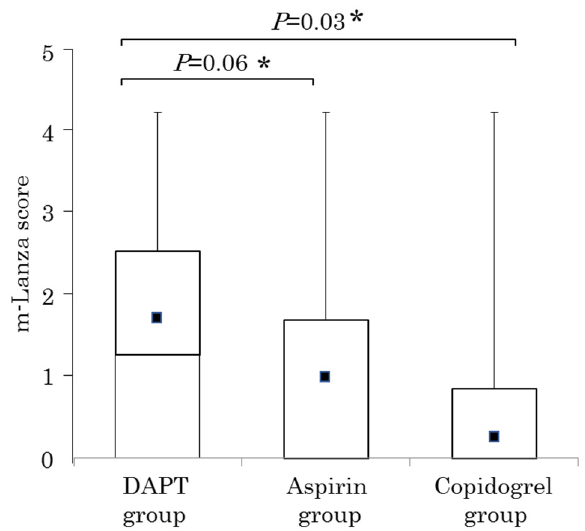
Figure 2. Box plots of the modified Lanza score (m-Lanza score) of the DAPT group, aspirin group, and clopidogrel group. ■ indicates the mean m-Lanza score. The m-Lanza score tended to be different among the DAPT group, aspirin group, and clopidogrel group ( p = 0.09 by the Kruskal–Wallis test). * Between the DAPT group and each of the aspirin or clopidogrel group ( p = 0.06 and p = 0.03, respectively, by the Mann–Whitney U test).